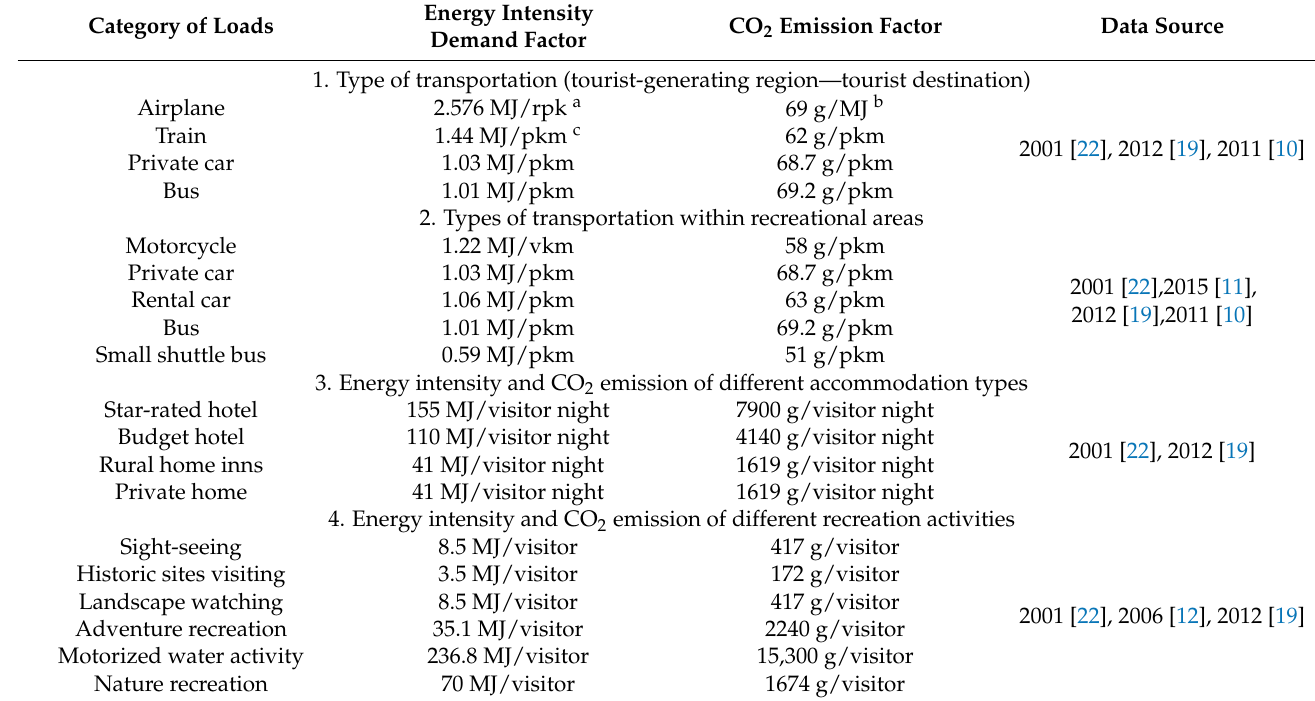
Table 3. The per capita data used in this